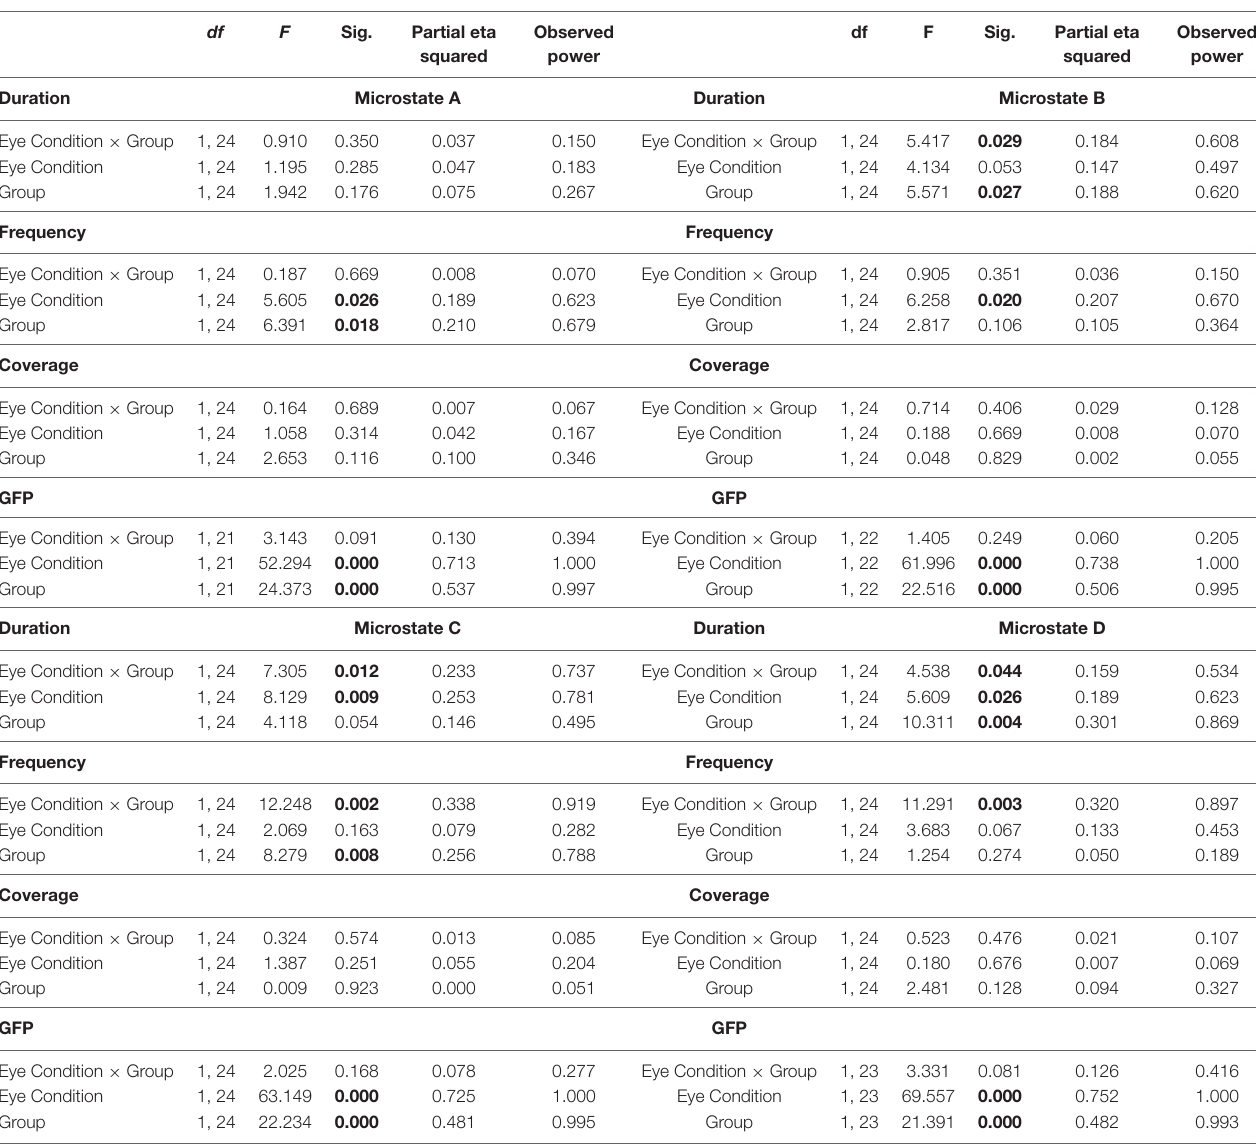
TABLE 3 | Results of RM-ANOVAs.